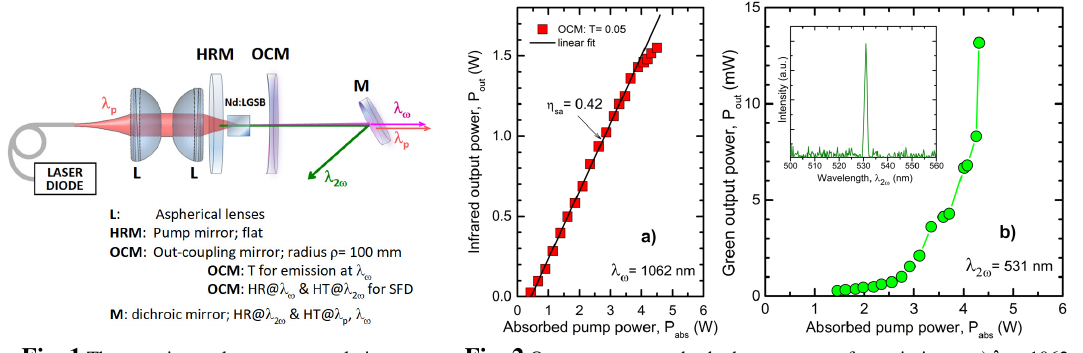
Fig. 1 The experimental set-up, general view. Fig. 2 Output power vs. aborbed pump power for emission at a) λ ω = 1062 nm and b) SFD at λ 2 ω = 531 nm. Inset shows the emission spectrum at 531